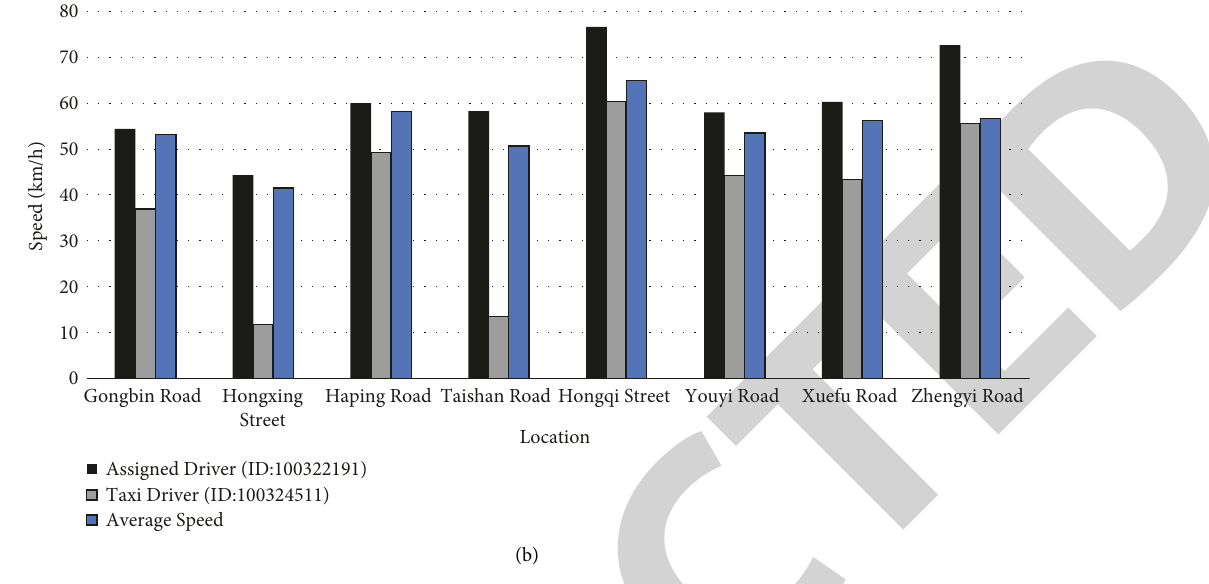
Figure 2: Speeds with different driving habits and the average speed: (a) speeds on the same road segment; (b) speeds at the same